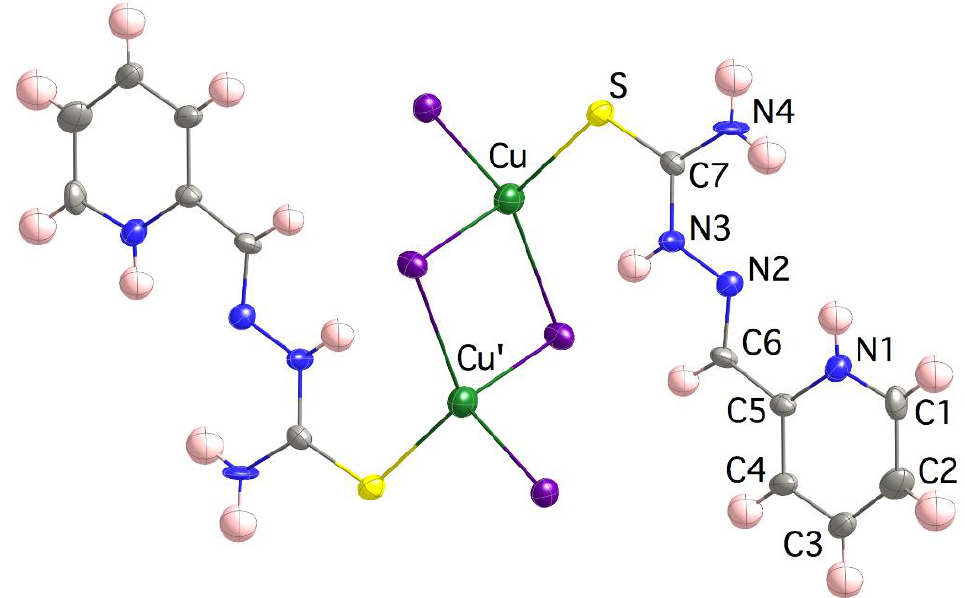
Figure 2. Crystal structure of the [{Cu(H 2 L)I 2 } 2 ] motives in 4 . Thermal ellipsoids are drawn at 30% probability level.